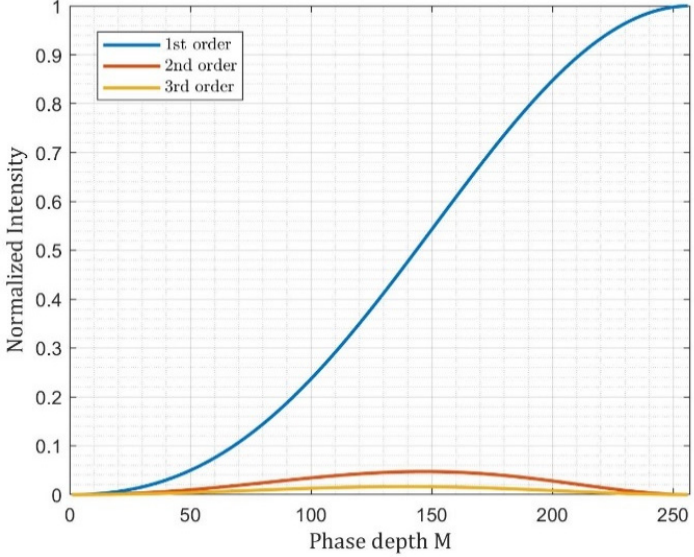
Figure 7. The intensity of different diffraction orders ( µ = 1, 2, 3) versus the phase depth M of a continuous phase grating ( N → ∞ ).